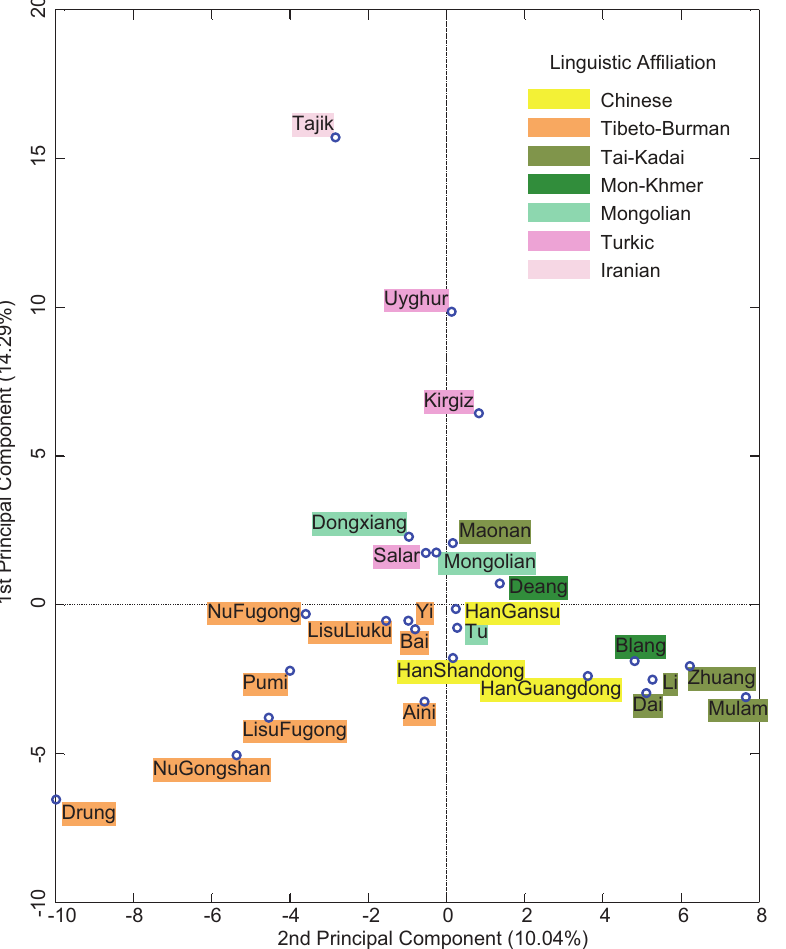
Figure 3. Principal component analysis with normalized allele frequencies for the full-loci dataset. Percentages of variance accounted for by the two components are indicated in labels. For better visual comparison with geographical distribution of studied populations, the plot was counter-clockwisely rotated 90 u . Colouring of linguistic affiliations follows that in Figure 2a.